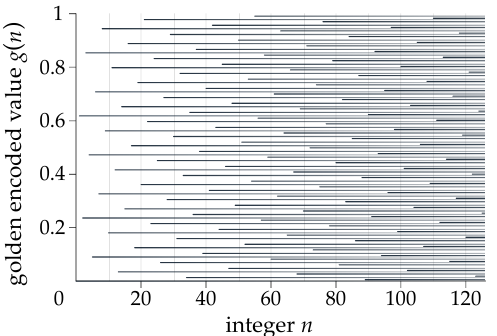
Figure 4. First 125 golden encoded values across interval [ 0,1 ] . Every value is projected horizontally to visualize the balanced accumulative distribution.